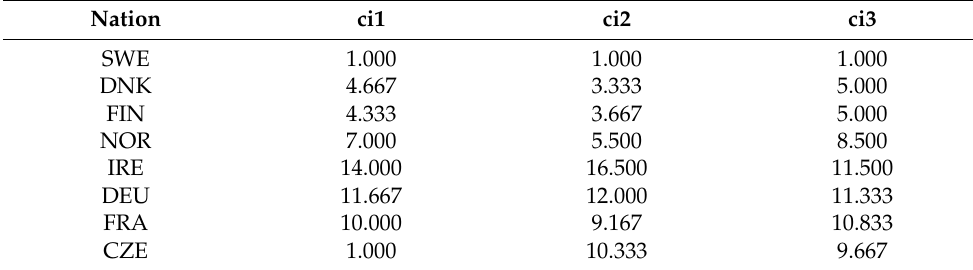
Table 5. The new MIS based on the generalized aggregation method.